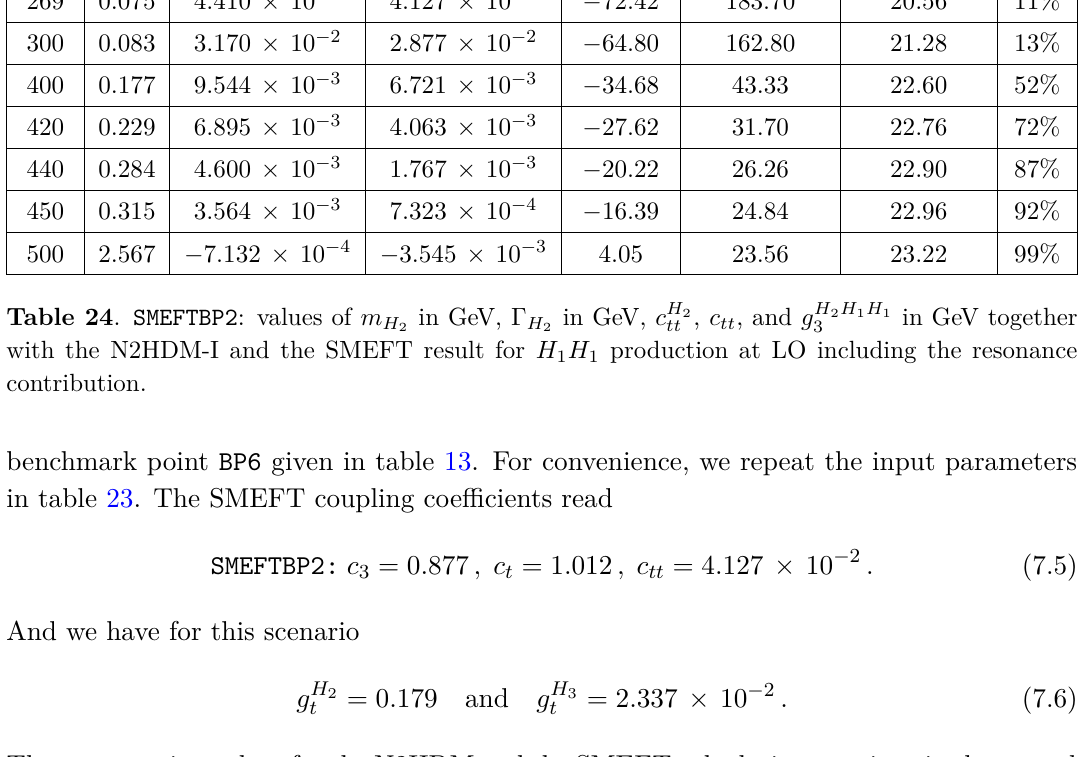
Table 24 . SMEFTBP2 : values of m H